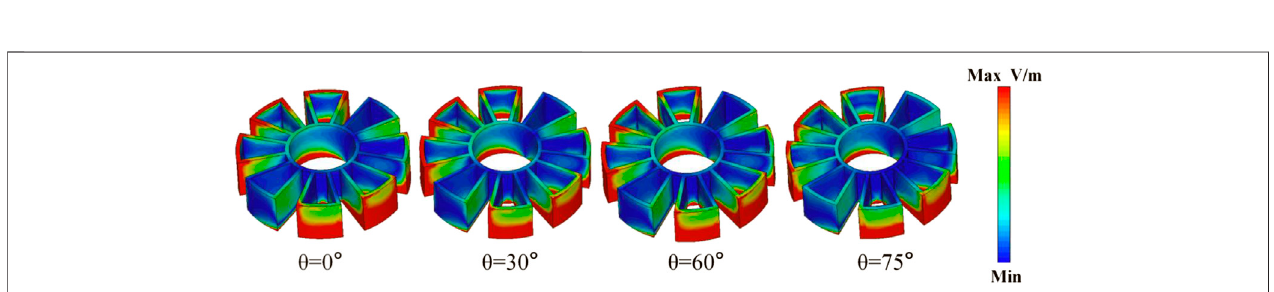
FIGURE 7 | Simulated electric fi eld distributions for TM polarization under different incident angles θ